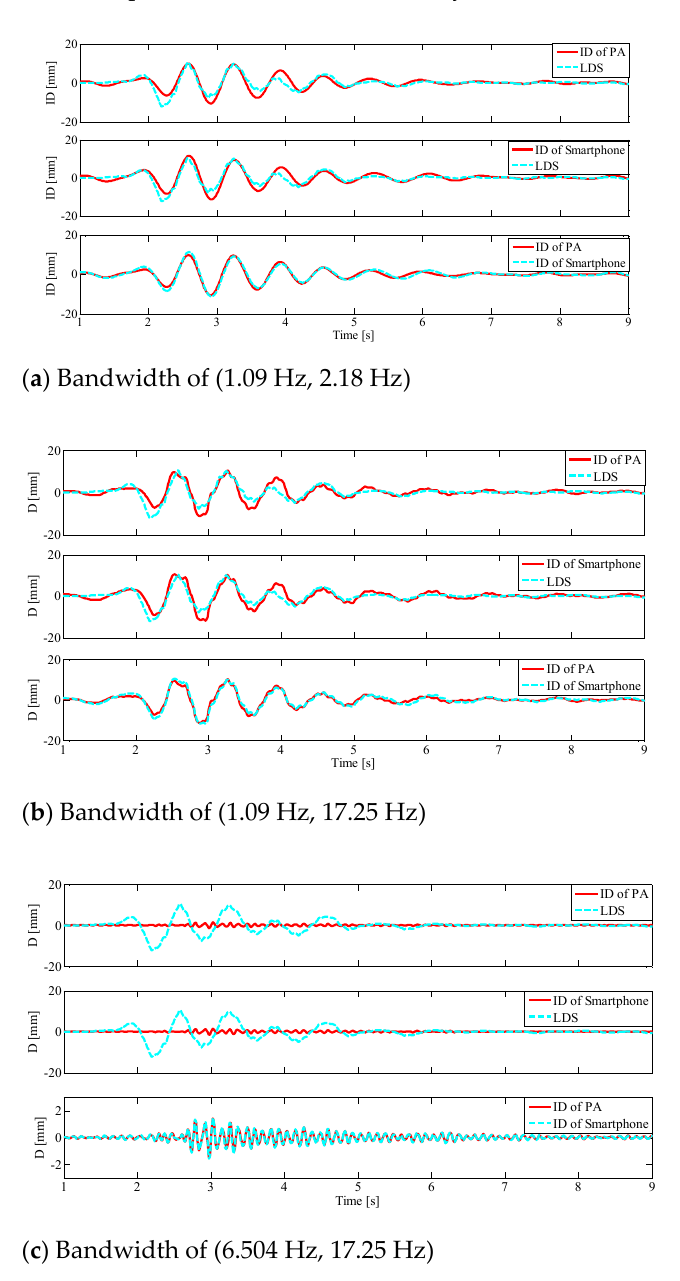
Figure 10. The comparisons between integrated and measured displacements of the first story (using data from PAs, LDS, and smartphones) for the damaged case are